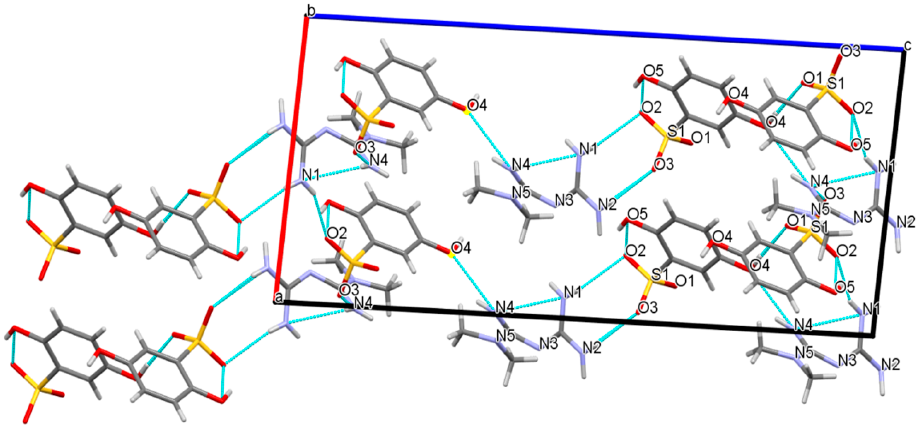
Figure 7. The two-dimensional hydrogen-bonding layered structure composed of MET and DBS along the b axis.